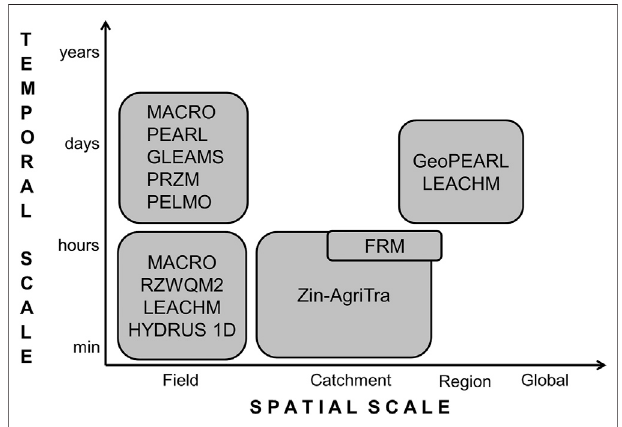
FIGURE 2 | Spatio-temporal resolution of investigated models. The temporal scale depicts the minimum output time step